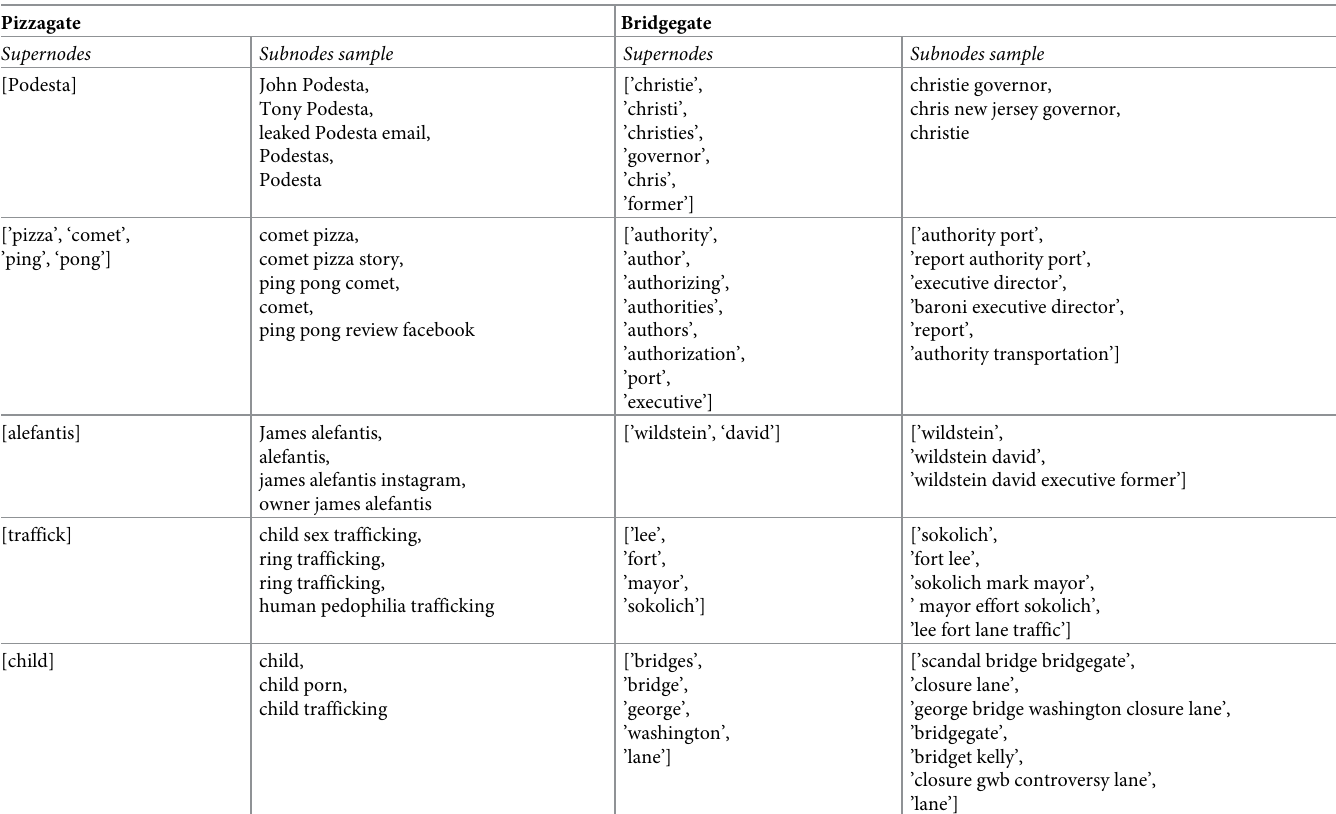
Table 2. A sample of the top 5 supernodes and subnodes for Pizzagate and